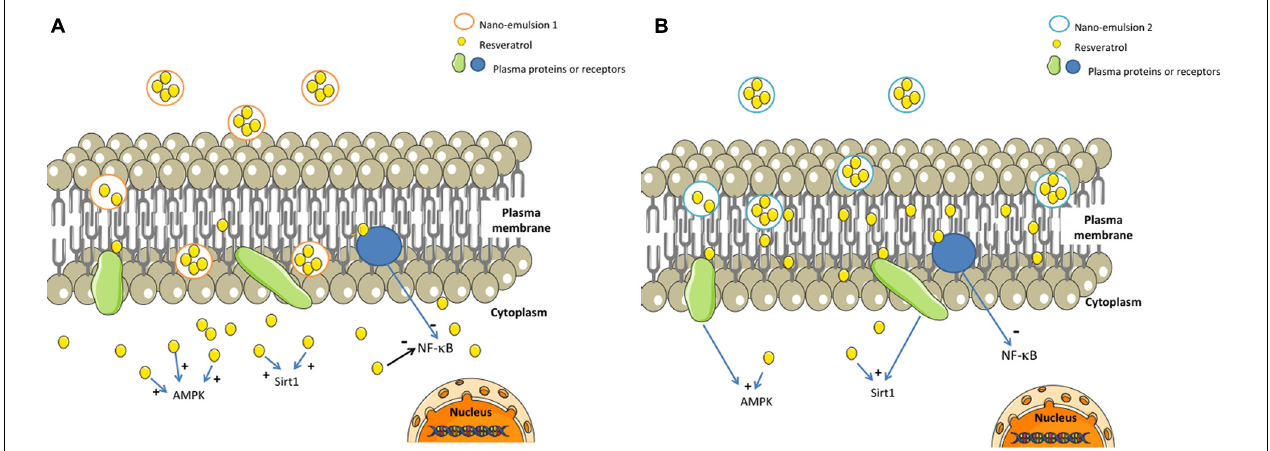
FIGURE 4 | Possible mechanisms of action of resveratrol-loaded NE 1 and NE 2. AMPK, adenosine monophosphate activated protein kinase; Res, resveratrol; Sirt 1, silent mating type information regulation 2 homolog 1. Resveratrol brought in NE 1 was able to cross the cellular membrane and to reach the cytoplasm (A) , whereas resveratrol brought by NE 2 was mainly localized inside the plasma membrane (B) . Both resveratrol-loaded NE were able to protect cells against oxidative stress-mediated